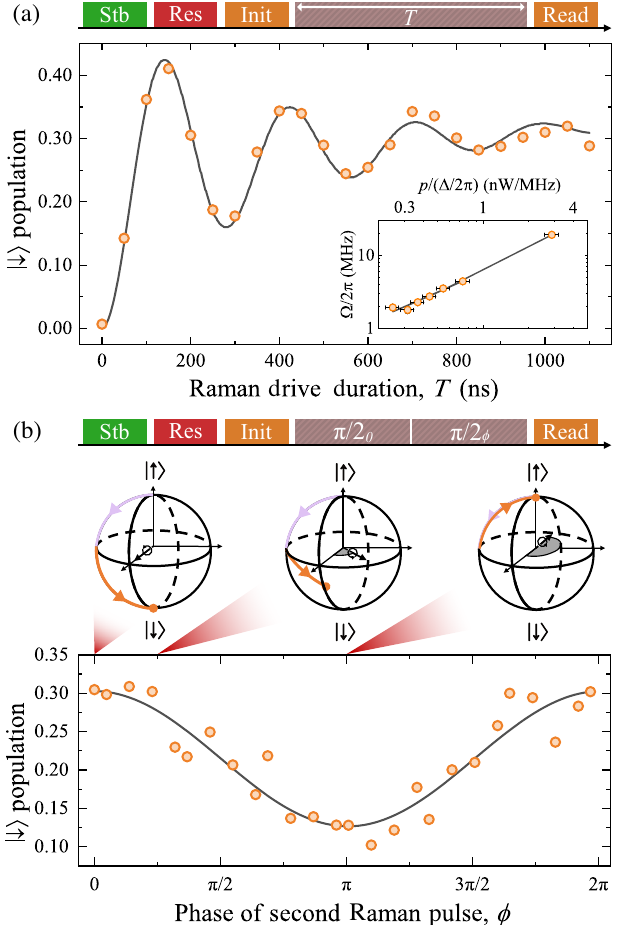
FIG. 2. Multiaxis coherent spin-qubit control. (a) j ↓ i popula- tion (orange circles) as a function of the Raman drive duration T with the pulse sequence shown at the top. The Raman drive is applied with Δ = 2 π ¼ 1 . 2 GHz and p ¼ 650 ð 70 Þ nW. The black curve is a fit to a two-level model under a master-equation formalism (see Supplemental Material [61] Sec. III). Inset: Ω = 2 π as a function of p= ð Δ = 2 π Þ with a linear fit to the data (solid curve). Here, Δ = 2 π and p are varied from 300 to 1200 MHz and 40 to 650 nW, respectively. (b) Pulse sequence (top) with one π = 2 pulse about x and a second about an axis rotated by an azimuthal angle ϕ from the x axis. The π = 2 pulse duration is determined from Rabi measurements taken with Δ = 2 π ¼ 300 MHz and p ¼ 260 ð 30 Þ nW. Illustrated on the Bloch spheres are trajectories for ϕ ¼ 0 (left), ϕ ¼ π = 4 (center), and ϕ ¼ π (right). The j ↓ i population (orange circles) is plotted as a function of ϕ . The solid curve is a cosine